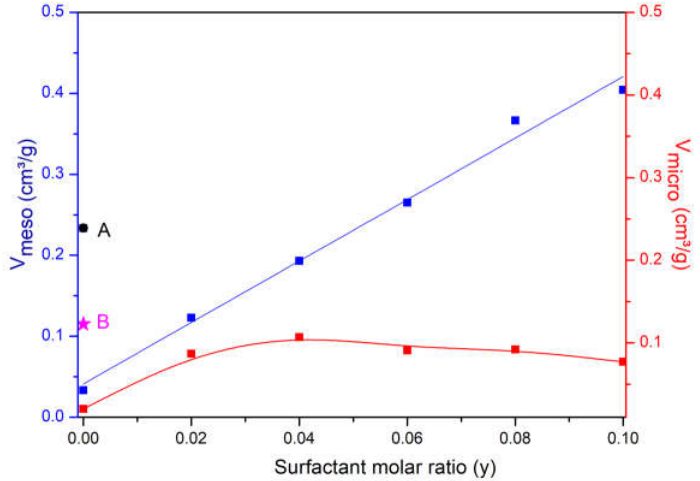
Figure 4. Micropore and mesopore volumes, as a function of surfactant molar ratio. A and B represent the volume of micropores and mesopores in the original USY zeolite, respectively.